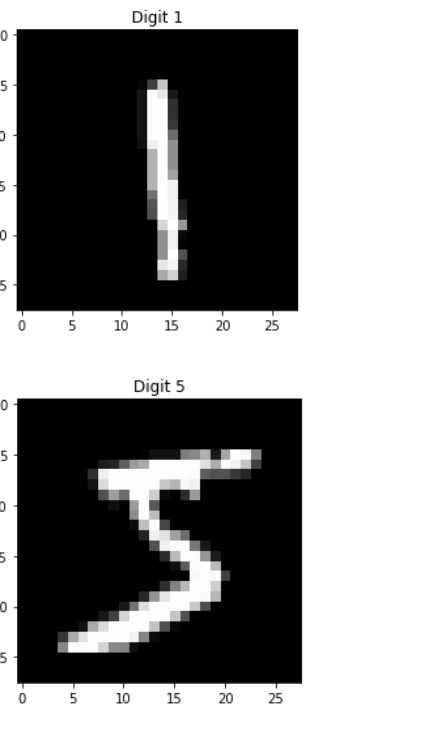
Figure 3 – Plotting samples from the MNIST dataset Рис. 3 – Формирование выборок из набора данных MNIST Слика 3 – Узорци добијени плотовањем за скуп података